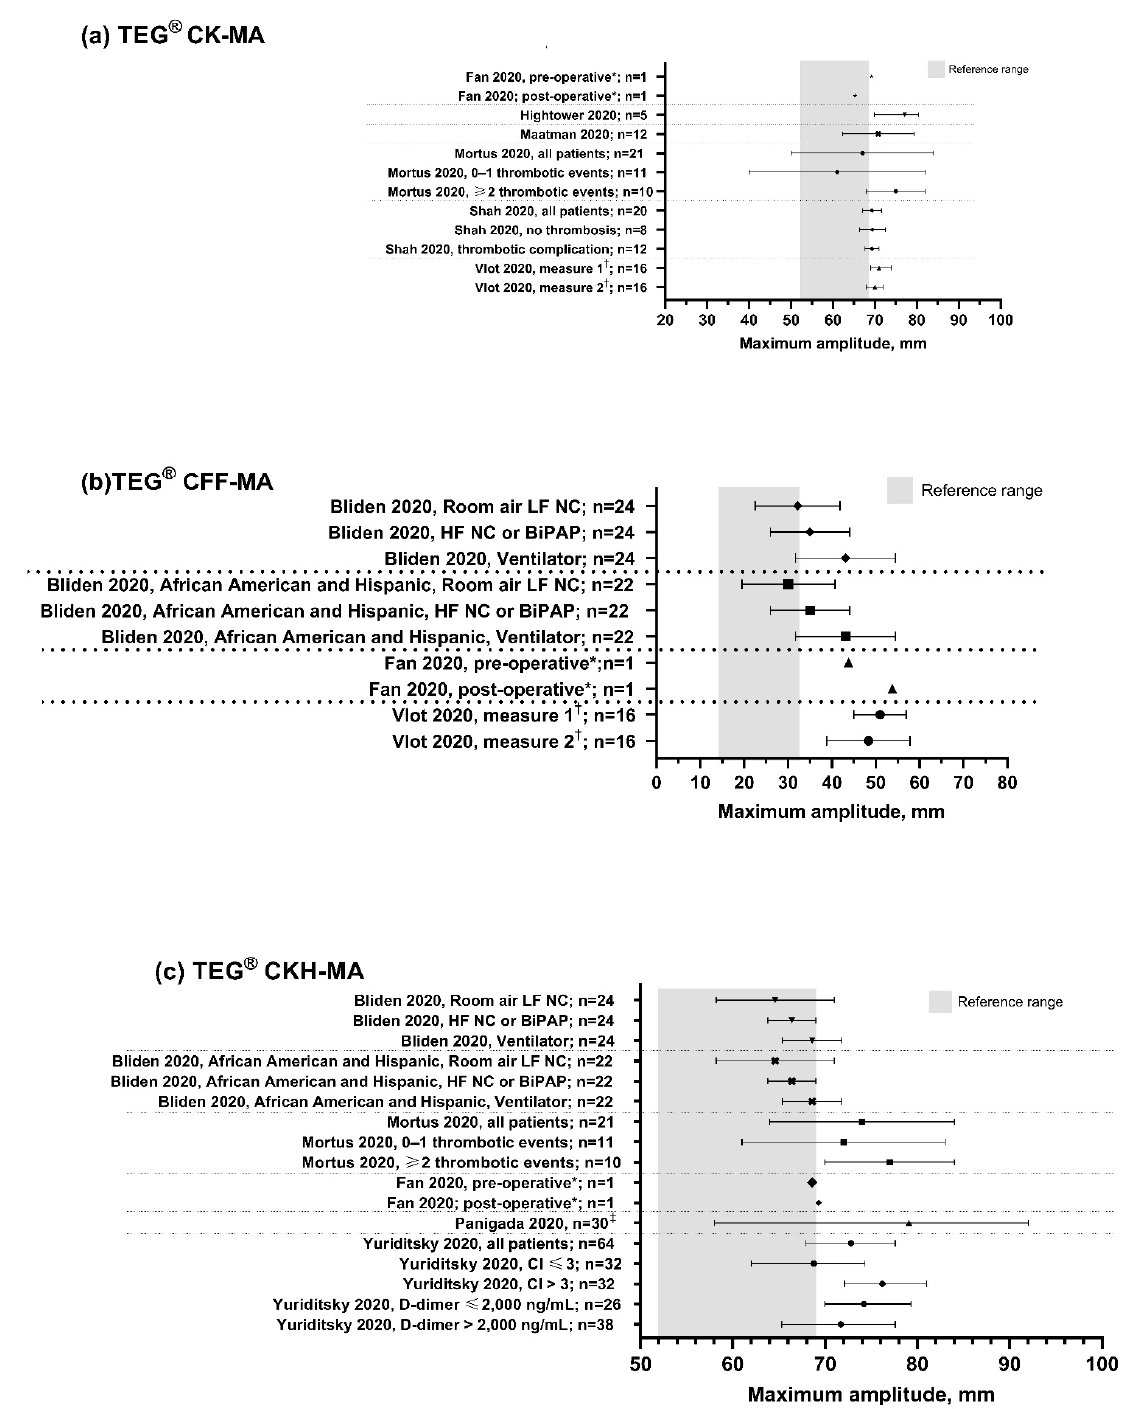
Figure 2. TEG MA values observed in patients with COVID-19. Grey bars show the normal TEG reference range [10]. CK, citrated kaolin assay; CFF, citrated functional fibrinogen assay; CKH, CK with heparinase assay; MA, maximum amplitude. * TEG measurements recorded before and after endovascular stent graft exclusion of the aortic thrombus and right lower limb embolectomy following diagnosis of acute ischemic limb. † Twice weekly TEG measurements recorded two weeks after the introduction of high-dose pharmacological thrombosis prophylaxis. ‡ Measurements were repeated on two consecutive days in six patients. Data points are mean with standard deviation error bars for normally distributed data, or median with interquartile range error bars for data that were not normally distributed. Dotted lines separate different studies with different patient populations. Data are not directly comparable between